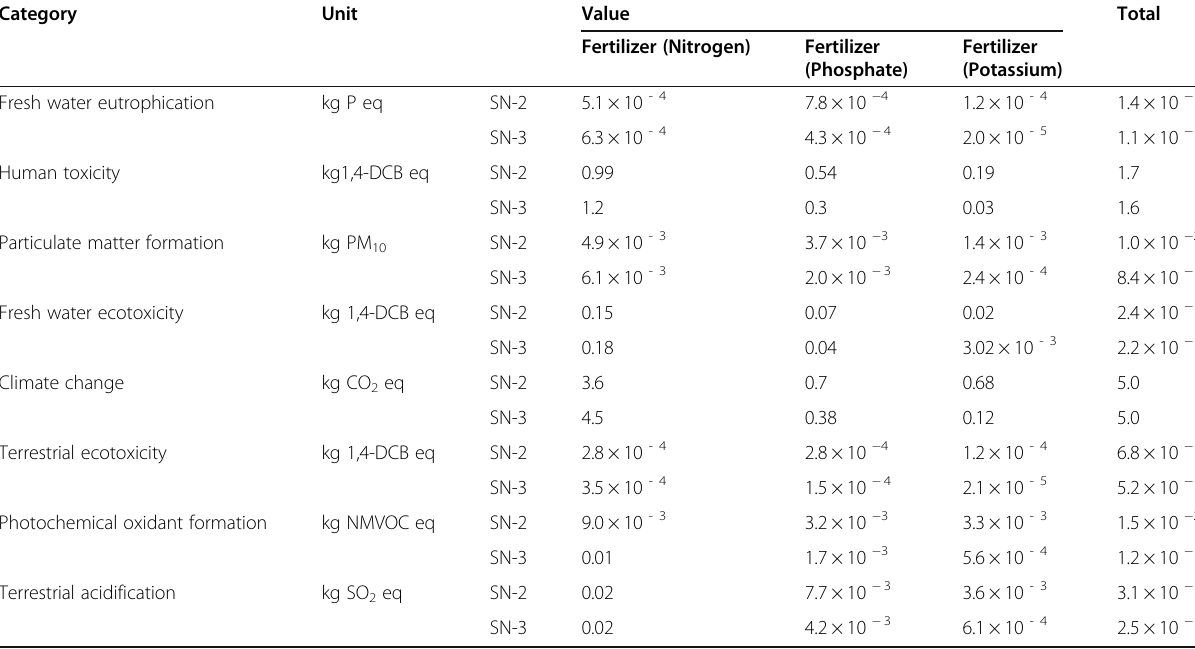
Table 6 Environmental impacts from the production of mineral fertilizers options (Ecoinvent v.3.6 database)